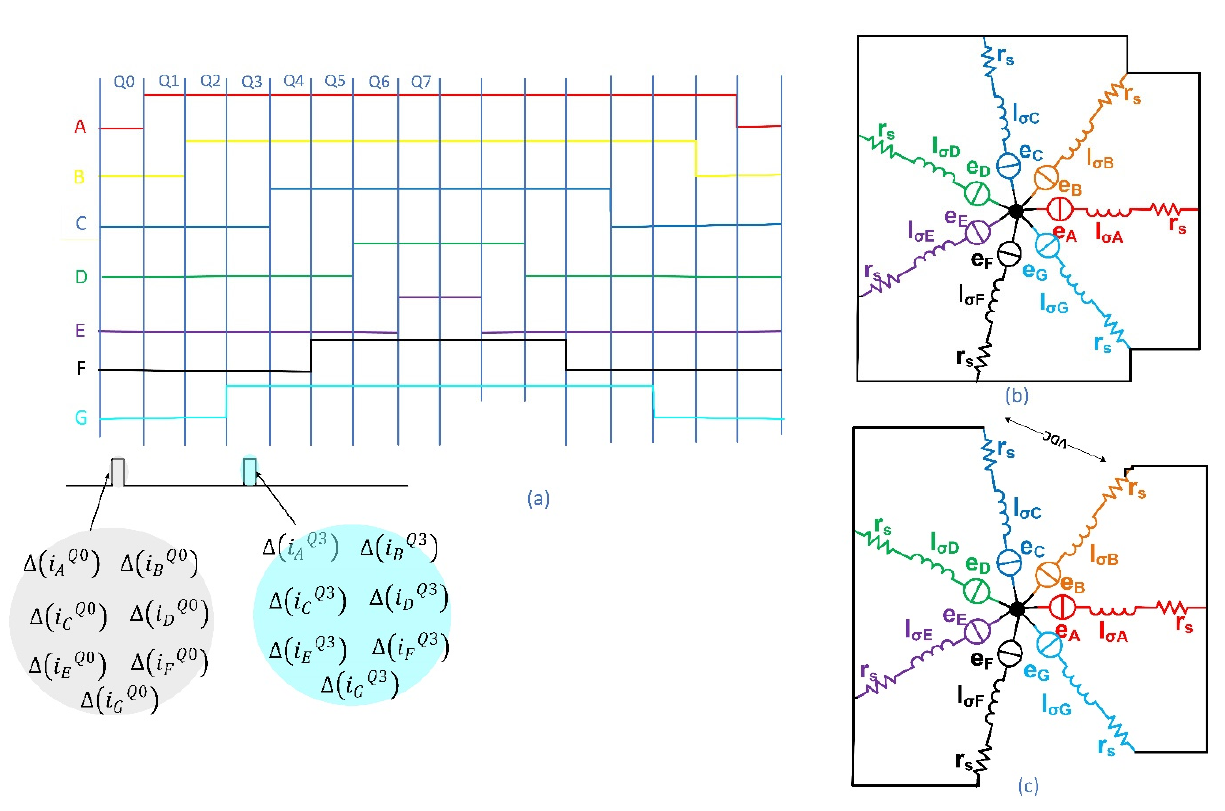
Figure 12. ( a ) Sampling instants when the current response of applying Q 3 and Q 0 are used to track the saliency, ( b ) dynamic circuit when Q 0 is applied, and ( c ) dynamic circuit when Q 3 is applied. The position scalars in other sectors are given in Table 5. Table 5. Saliency position scalars in each sector of the seven-phase PMSM using Q 3 (case = 2). Sector